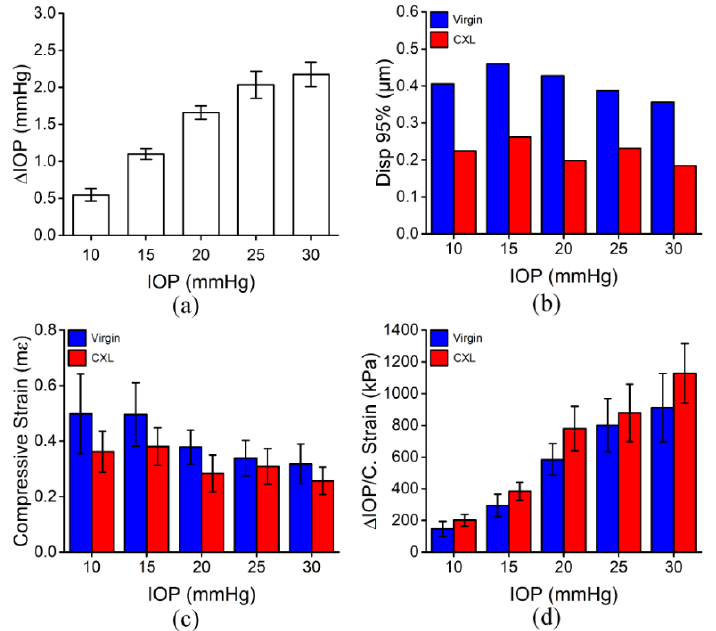
Figure 6. Results of the half-CXL in situ rabbit cornea sample (N = 1). ( a ) The difference in IOP between the unloaded and loaded states, ( b ) 95th percentile of the displacement, ( c ) strain, and ( d ) stiffness as quantified by ΔIOP/strain as a function of baseline IOP. The data is plotted as the inter-cycle mean ± standard deviation in ( a ) and intra-region mean ± standard deviation in ( c , d ).